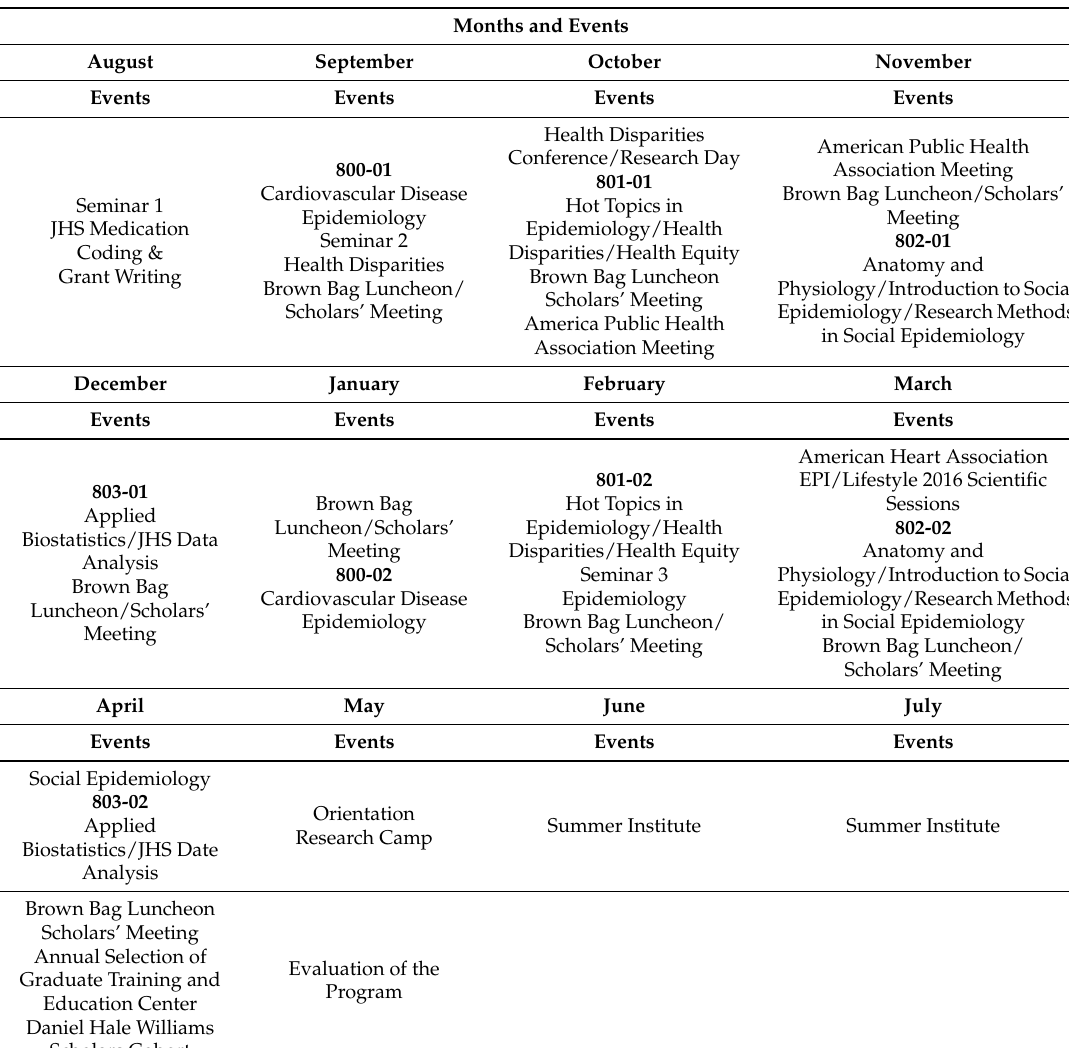
Table 4. GTEC DHWS Program/Schedule of